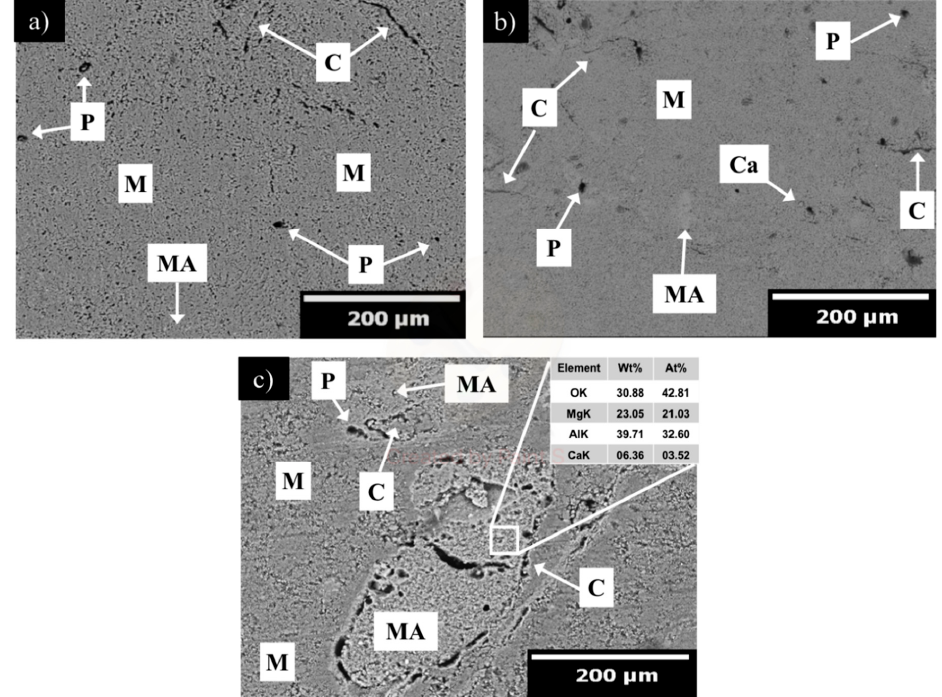
Figure 6. SEM micrograph of microstructural evolution of magnesia samples with increasing addition of α -Al 2 O 3 nanoparticles, sintered at 1300 °C. ( a ) 1, ( b ) 3, and ( c ) 5 wt.%. M = magnesia, C = microcracks, P = pores, and MA = MgAl 2 O 4 spinel.